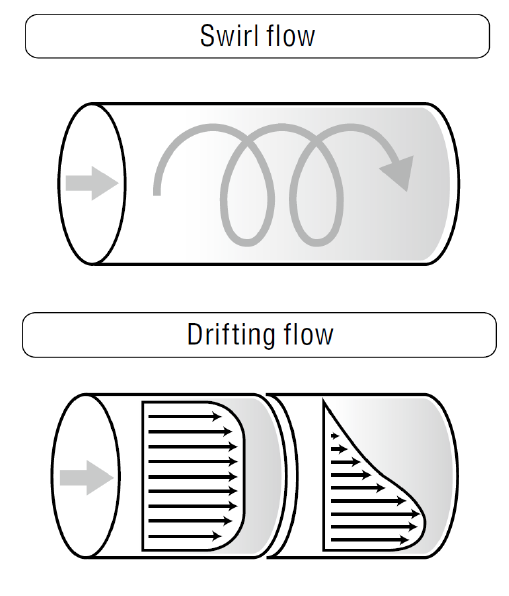
Fig. 1. Swirl flow and drifting flow – basic distortions in closed conduits [3].